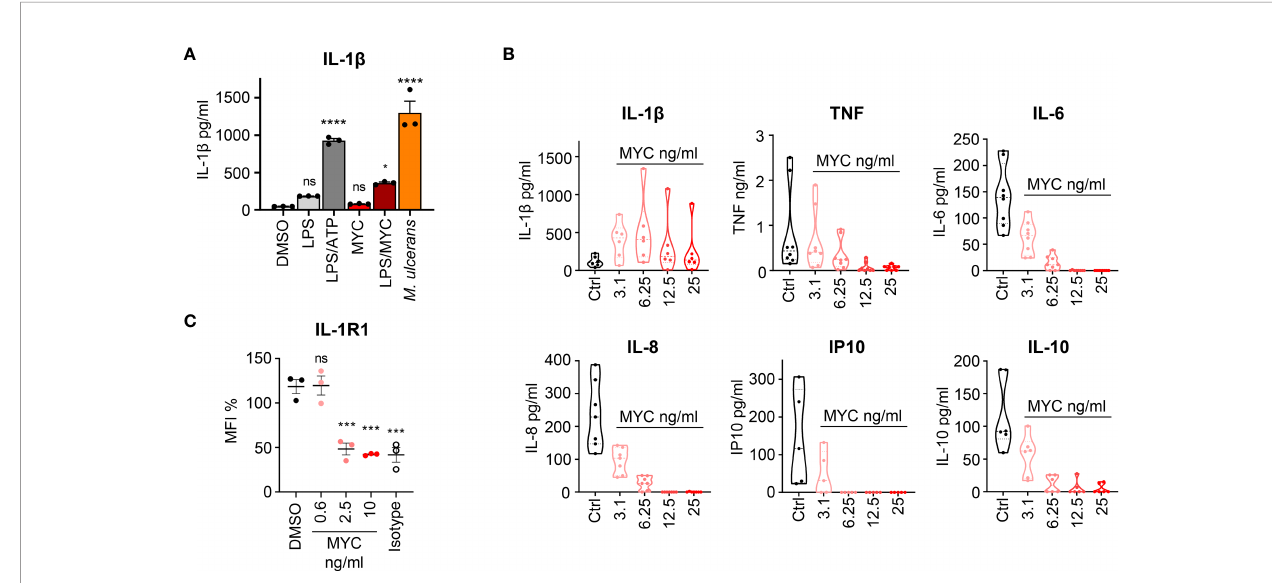
FIGURE 2 | Induction of macrophage IL-1 b activation and secretion by M. ulcerans . (A) IL-1 b production by PMA-activated THP-1 cells incubated for 24 h with 0.05% DMSO, 10 ng/ml E.Coli -derived LPS (Enzo) with or without 1 mM ATP or 31.25 ng/ml synthetic mycolactone (MYC) or M. ulcerans Mu_1082. At this time point THP-1 cell viability was >95%. IL-1 b was measured by ELISA (eBioscience) in triplicate (mean ± SD). Results are representative of duplicate experiments. (B) Rheumatoid arthritis (RA) synovial membrane cultures were isolated as in (67) and then cultured in medium alone or medium containing increasing concentrations of natural mycolactone (MYC) for 24 h. The concentration of IL-1 b , TNF, IL-6, IL-8, IP-10 and IL-10 in the cell supernatants were measured by ELISA (68 – 70). This mixed cell population, including predominantly CD45 - fi broblast-like cells, CD14 + CD45 + macrophages and CD3 + CD4 + T lymphocytes, are highly activated, and spontaneously produce cytokines without further stimulation. In addition to those shown, these cells also secrete other cytokines/chemokines/in fl ammatory mediators including CCL5, CCL2, GM-CSF, IL-23, IL-17, IL1RA, IL-11,TNFRSF1B (TNFR2), MMP1, MMP2, MMP3, MMP13, and TIMP1, but not IFN g or lymphotoxin (67, 71 – 76). All RA patients gave written informed